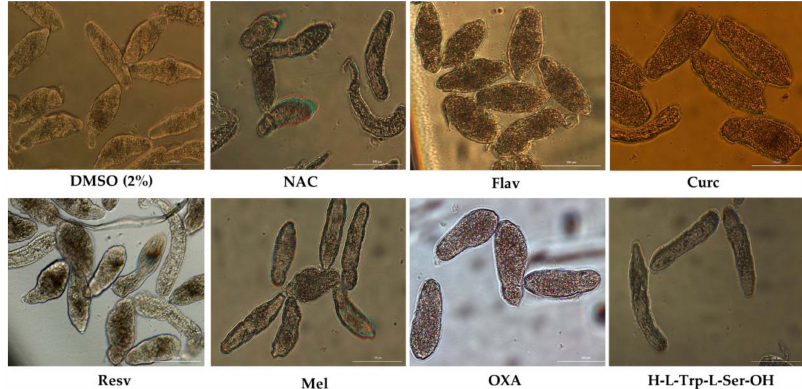
Figure 2. Representative micrographs of NTS at 72 h of incubation in antioxidants at 100 µ M. Notable differences were evident among controls and NTS incubated with 4-phenyl-1,2,5-oxadiazole- 3-carbonile-2-oxide (OXA), curcumin (Curc), and flavone (Flav), which induced severe granularity and reduced activity. In contrast to OXA and Curc, Flav did not kill all the NTS. Resveratrol (Resv) also induced moderate morphological alterations but did not kill all NTS. N -acetylcysteina (NAC), melatonin (Mel) and dipeptide (DiPept) did not induce significant morphological alterations. Scale bar, 100 µ m.